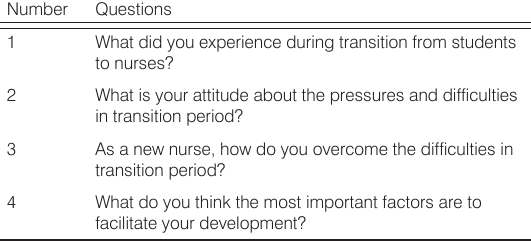
Table1. Demographic characteristic of the participants ( N =